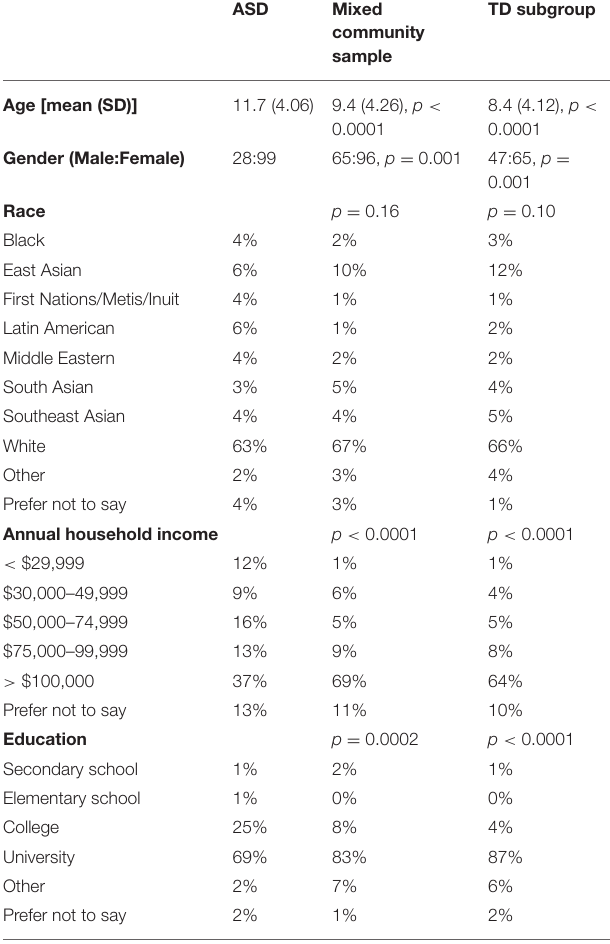
TABLE 1 | Participant demographics. Analyses revealed a significant increase in total screen time